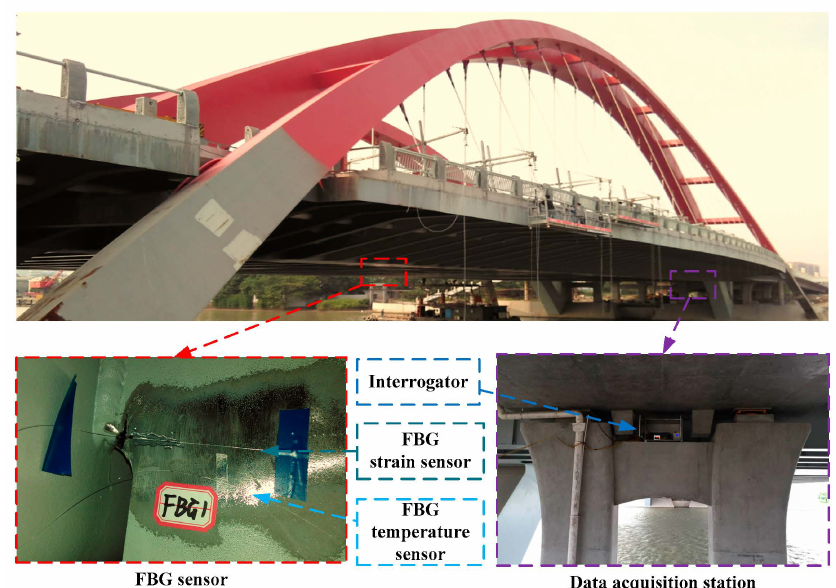
Figure 9. Deployment of structural health monitoring (SHM) system based on fiber Bragg grating (FBG) [151].